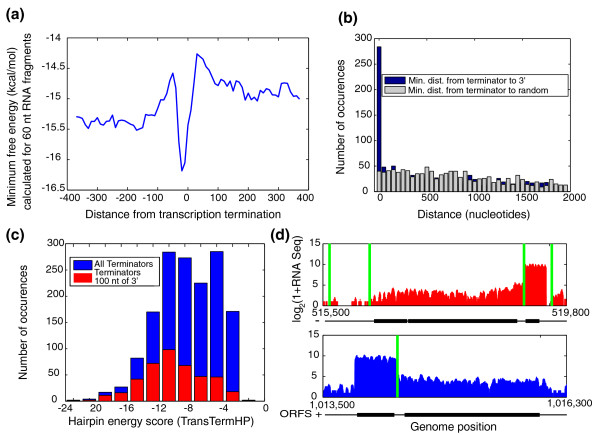
Transcription termination in S. elongatus. (a) Minimum RNA free energy at the end of transcripts. The minimum free energy of 60-nucleotide RNA fragments with 10-nucleotide spacing was calculated and averaged for all mRNAs (Materials and methods). A drop in minimum free energy at the 3' end is indicative of Rho-independent transcription termination. (b) Distance between TransTermHP bioinformatically predicted terminators and 3' ends. Predicted intrinsic terminators (from TransTermHP [29]) tend to be much closer to the 3' end of transcripts than to random positions occurring at the same frequency as 3' ends. Blue bars show distance from a predicted terminator to the closest 3' end. As a control, we randomized the location of 3' ends in the genome. Grey bars show distance from a predicted terminator to the closest randomized 3' end. (c) Energy distributions of TransTermHP terminators. Not all predicted TransTermHP terminators cause transcription termination. Several terminator-like structures are located in non-transcribed regions or in the middle of transcripts. The free energy of terminators that cause transcription termination tends to be lower than the free energy of those that do not. The P-value is 3.00e-20 by two-sided Wilcoxon rank sum test. (d) Partial transcription termination creates complex transcriptional structures. Positive strand transcription is shown in blue and negative strand transcription in red. The positions of predicted terminators (from TransTermHP) are shown in green, and the position of JGI predicted ORFs are shown in black. Terminators located within transcripts often result in a decrease in the transcription of downstream ORFs.